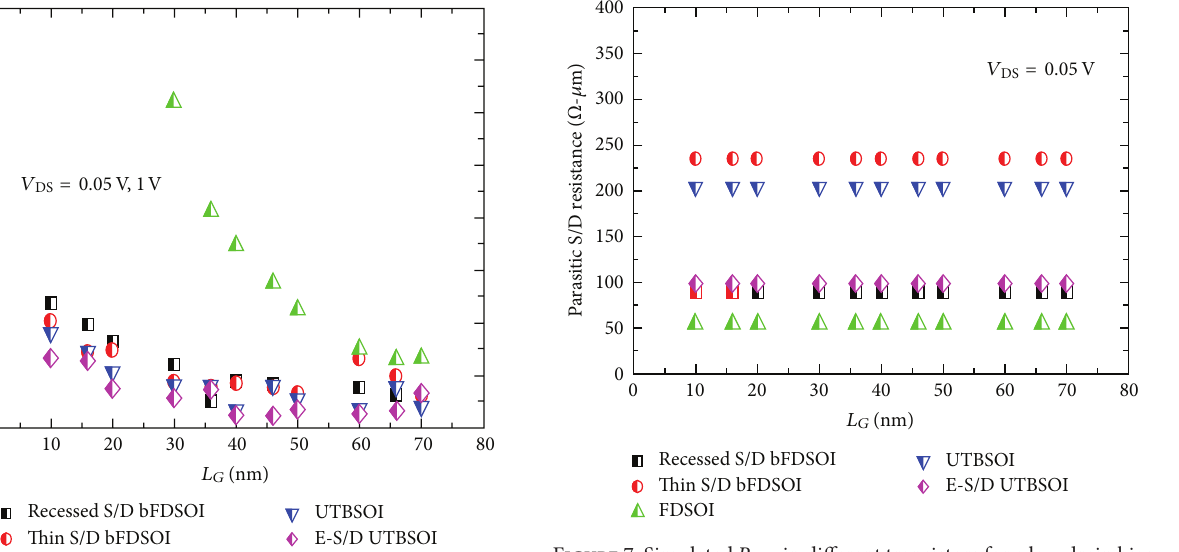
versus 𝐼 for the MOSFETs at 𝑉 OFF ON